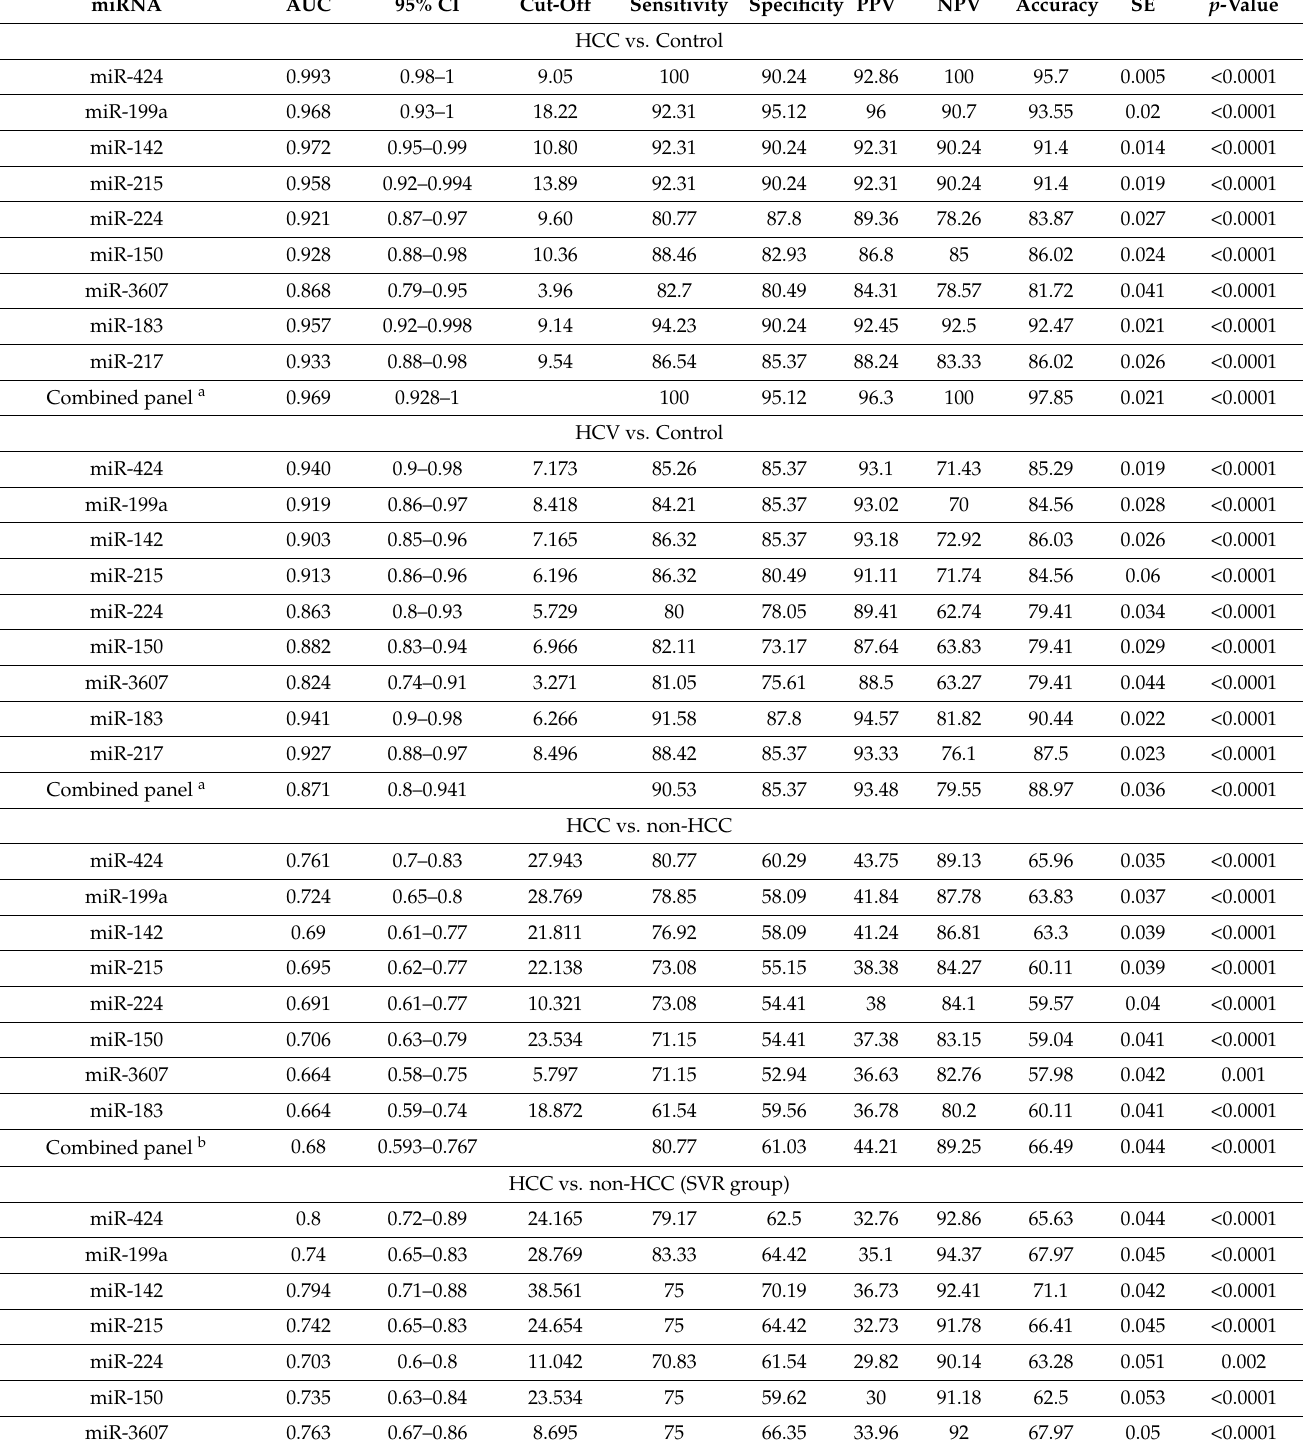
Table 7. Diagnostic accuracy of single and combined miRNAs between HCC relative to healthy control and non-HCC